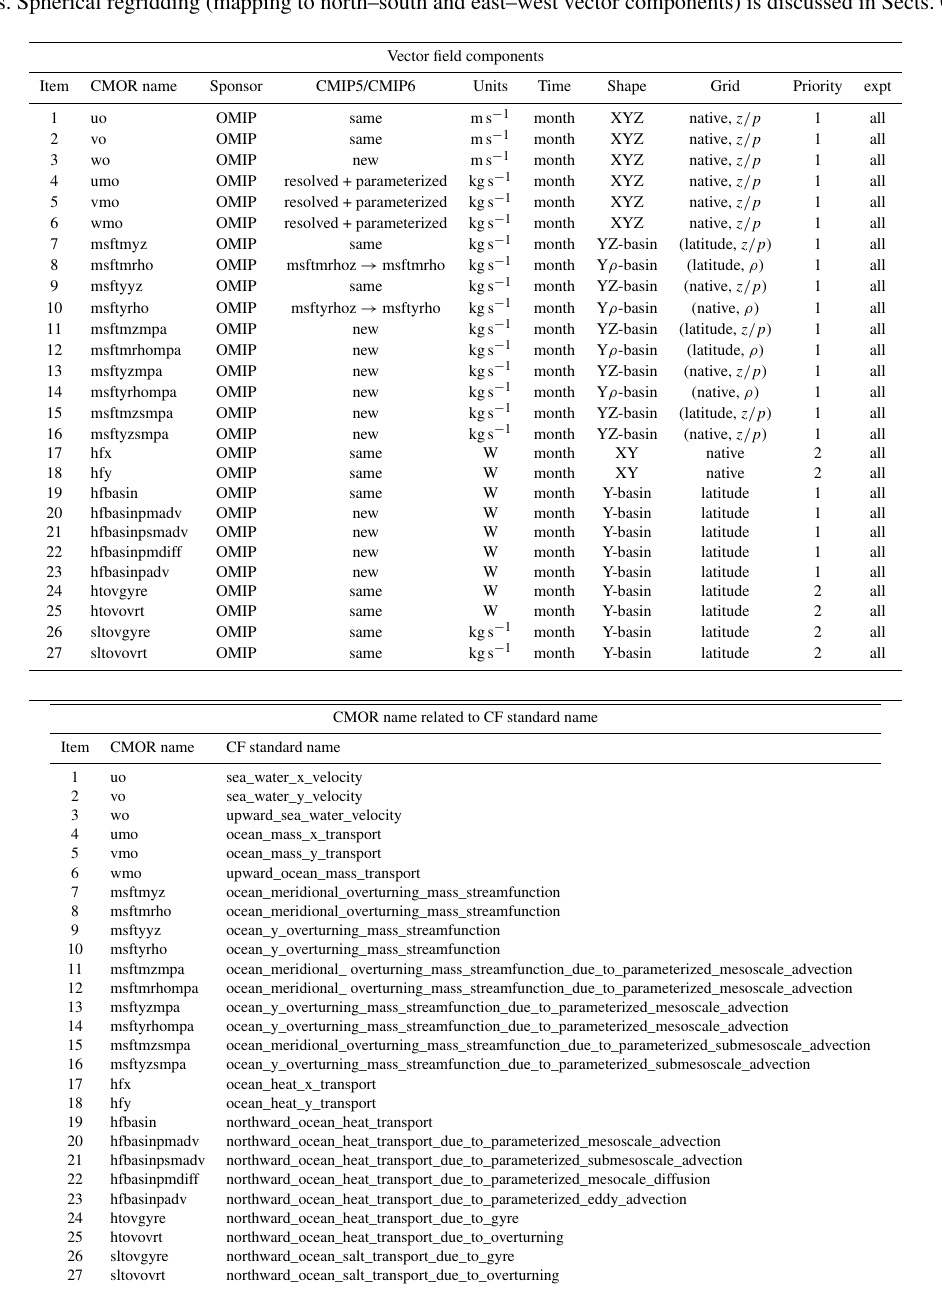
Table I1. Diagnostic table for vector components, including a sub-table relating the CMOR name to its CF standard name. Note that as per the discussion in Sect. A3, we generally recommend native grid sampling of vector field components, with the exception of unstructured mesh models. The column indicating the experiment for saving the diagnostics generally says “all”, in which case we recommend the diagnostic be saved for CMIP6 experiments in which there is an ocean model component, including the DECK, historical simulations, FAFMIP, DAMIP, DCPP, ScenarioMIP, and C4MIP, as well as the ocean/sea-ice OMIP simulations. The Priority 1 diagnostics should be saved as decadal time means at decadal intervals for the piControl spin-up. Some of the fields in this table should be partitioned into Atlantic–Arctic, Indian–Pacific, and global regions. Spherical regridding (mapping to north–south and east–west vector components) is discussed in Sects. C3 and